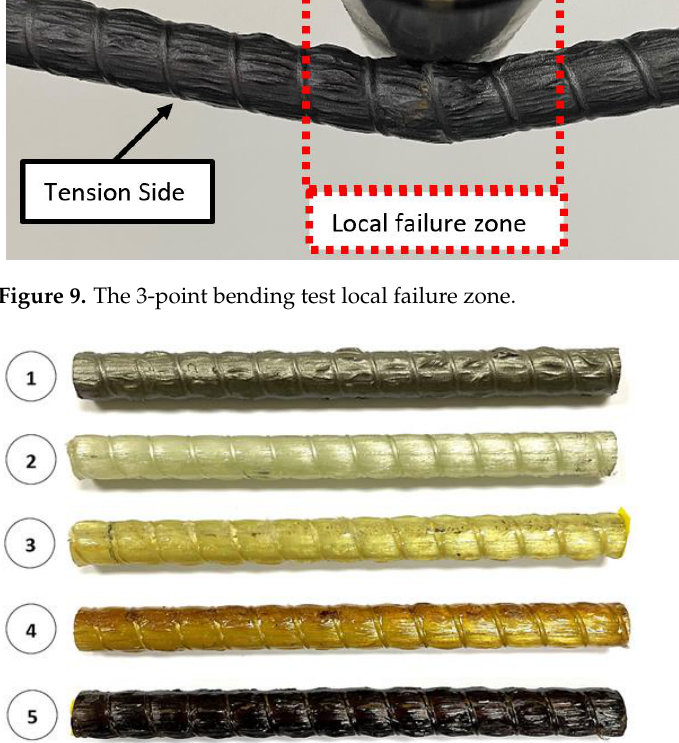
Figure 10. Specimens after exposure to the elevated temperatures. ( 1 ) Coated specimen, ( 2 ) uncoated at T1, ( 3 ) uncoated at T2, ( 4 ) uncoated at T3, and ( 5 ) uncoated at T4 .